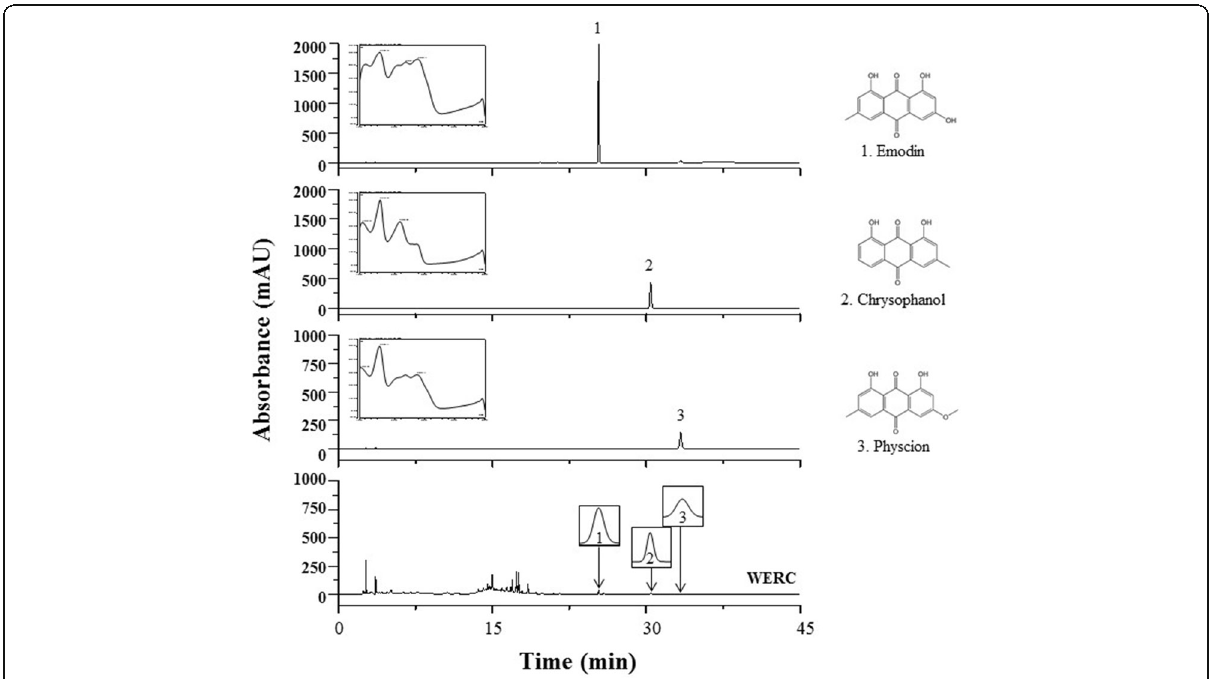
Fig. 1 HPLC-DAD chromatogram of WERC and three standard components (emodin, chrysophanol, and physcion) at wavelengths of 280